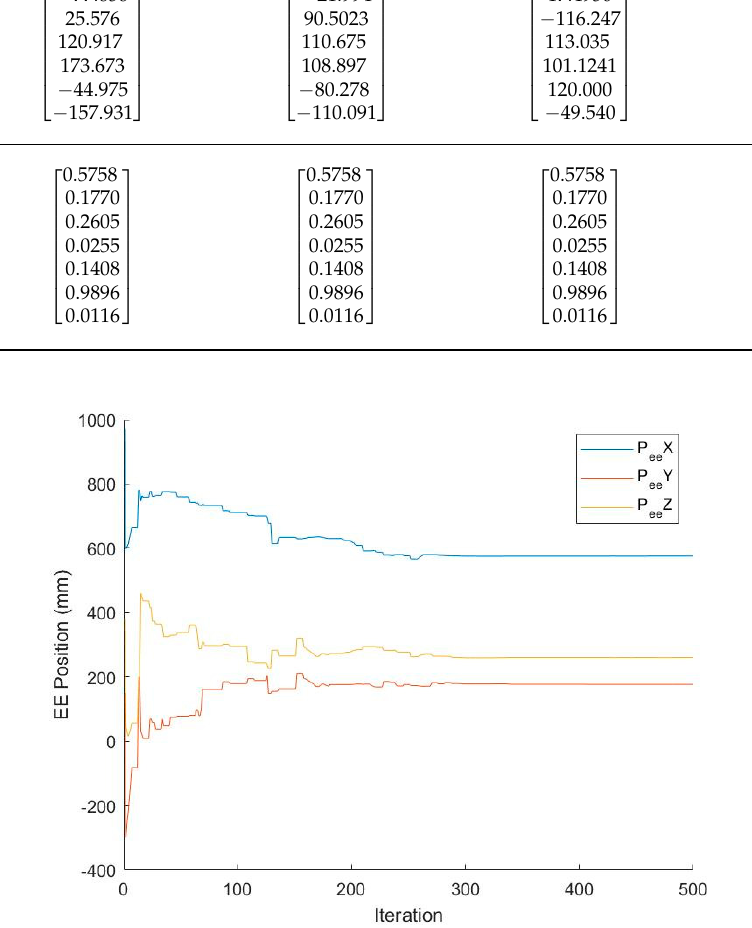
Figure 3. Plot of run 1 EE position.